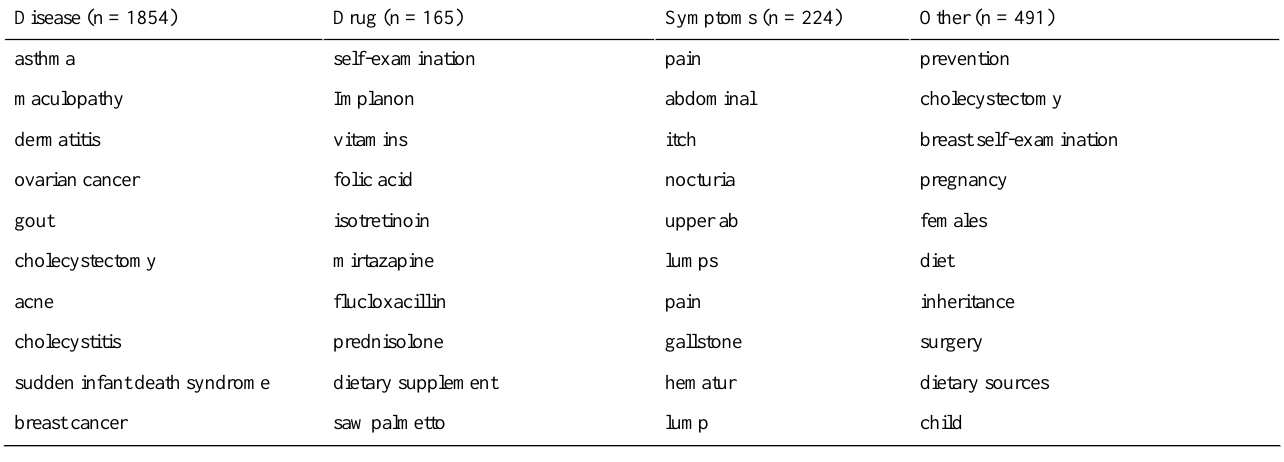
Table 3. Top 10 keywords used to describe clinical questions (N = 2543